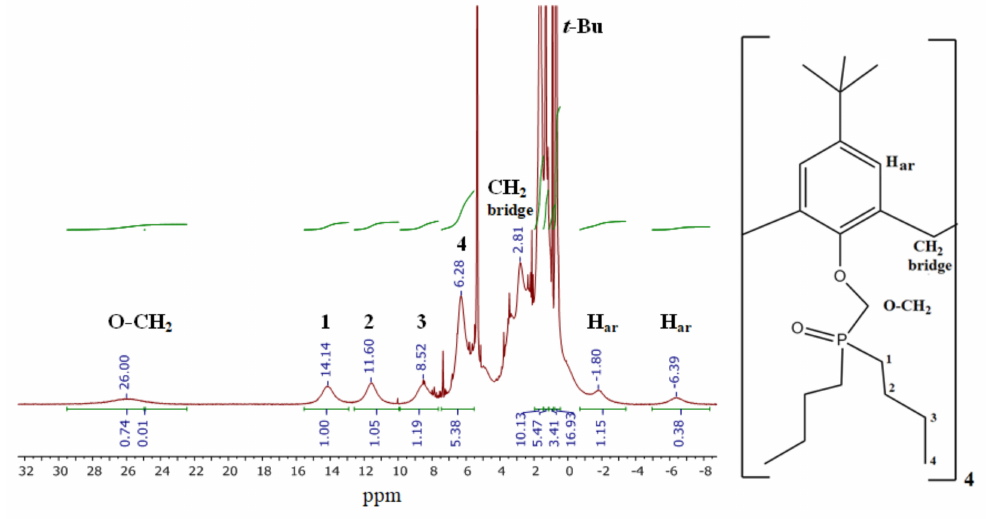
Figure 1. 1 H NMR spectra of Co-calix[4]arene at 310